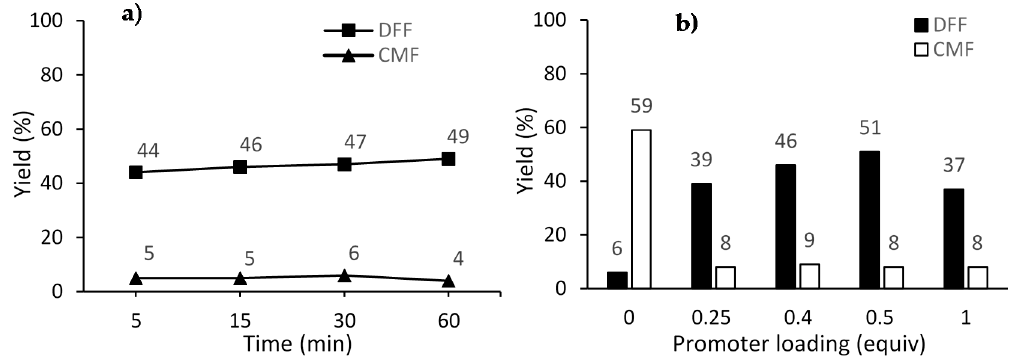
Figure 1. Oxidation of CMF for ( a ) different reaction times at 140 °C using 0.5 equiv. of Cu(OTf) 2 ; ( b ) different promoter loading at 160 °C for 5 min. Reaction conditions : microwave irradiation (MWI), CMF (0.35 mmol, 50 mg), 4 equiv. of pyridine N -oxide, in CH 3 CN (0.5 M). Yields were determined by 1 H-NMR analysis of the crude reaction mixture using 1,3,5-trimethoxybenzene as internal standard.